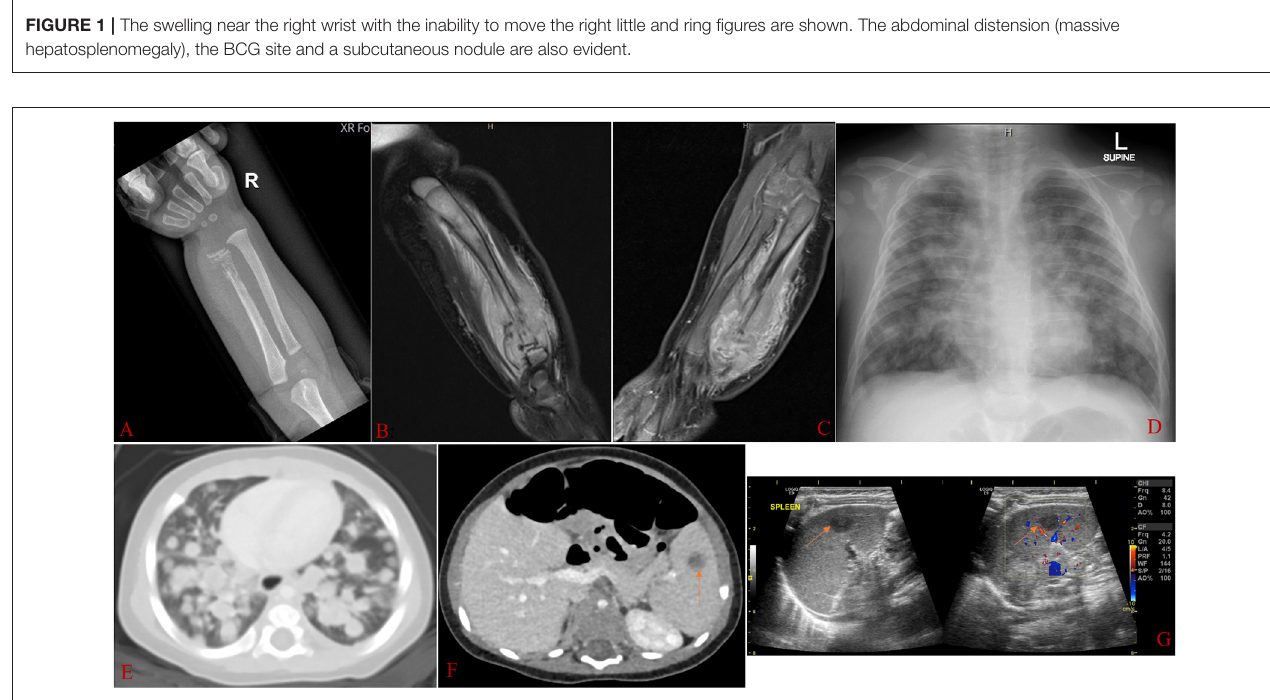
FIGURE 2 | Radiographic images taken at about 3 ½ months of age. (A) : Radiograph of the right forearm showing abnormal texture in the distal ulnar, with areas of bone destruction and resorption surrounded by soft tissue swelling. (B,C) : MRI of the right forearm (with and without contrast) showing destructive bone lesion involving the ulnar with a large, enhancing soft tissue mass extending into the interosseous space, measuring 2.5 × 2.5 × 4.5cm. The mass involves the diaphysis and distal metaphysis. There is periosteal reaction and edema in the surrounding soft tissue and subcutaneous fat. There is also abnormal signal and enhancement of the distal ulnar growth plate with displacement. (D,E) : Chest radiograph and chest CT scan showing nodular lesions in both lungs. (F,G) : Abdominal CT scan and ultrasound showing the right hepatic lobe exceeding the costal margin, measuring 8.6cm craniocaudally. The spleen measures 7.0cm in length and shows two focal hypodense lesions, the largest measuring 1.01 × 0.86cm